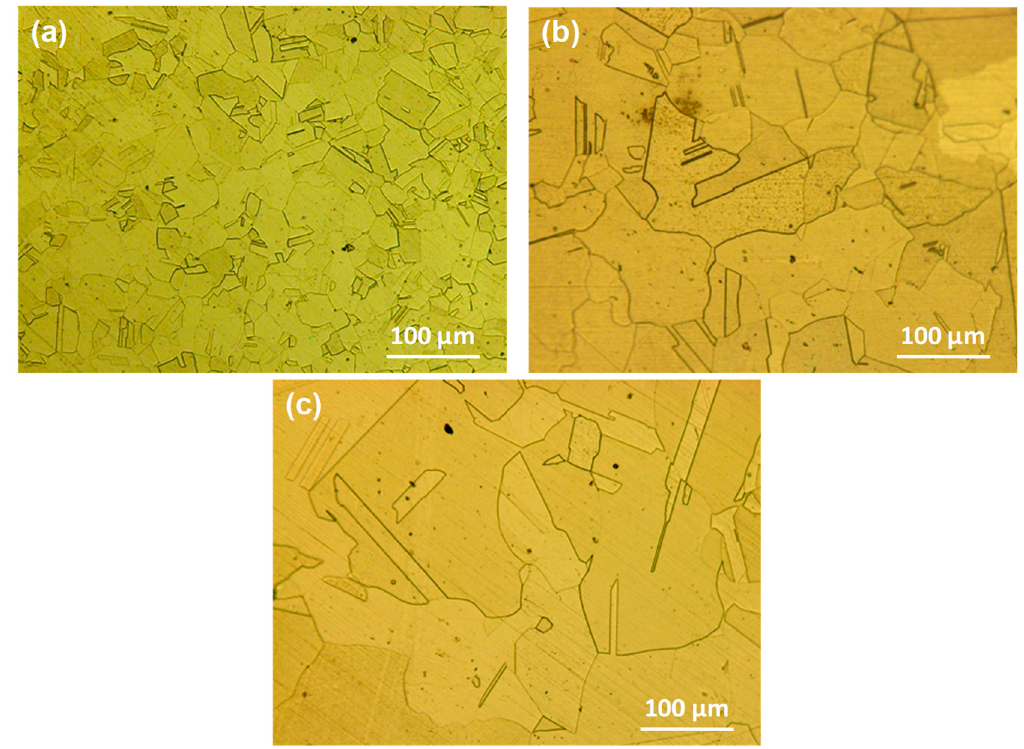
Figure 4. Optical microstructures of 309 SS ( a ) before and after thermal fatigue tests under different T max conditions: ( b ) 800 °C and ( c ) 900 °C.